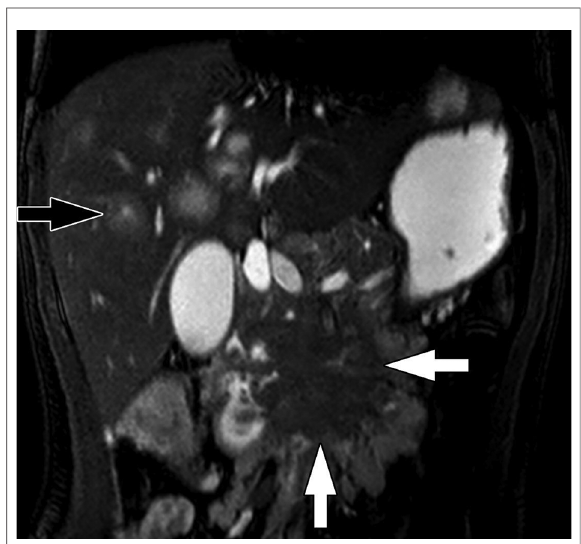
FIGURE 4 Pancreatic ductal adenocarcinoma. Coronal T2-weighted fat- saturated MRI of the abdomen shows a hypointense in fi ltrative mass involving the head and uncinate process of the pancreas (white arrows). There are additionally ill-de fi ned hyperintense metastases in the liver (one indicated by the black